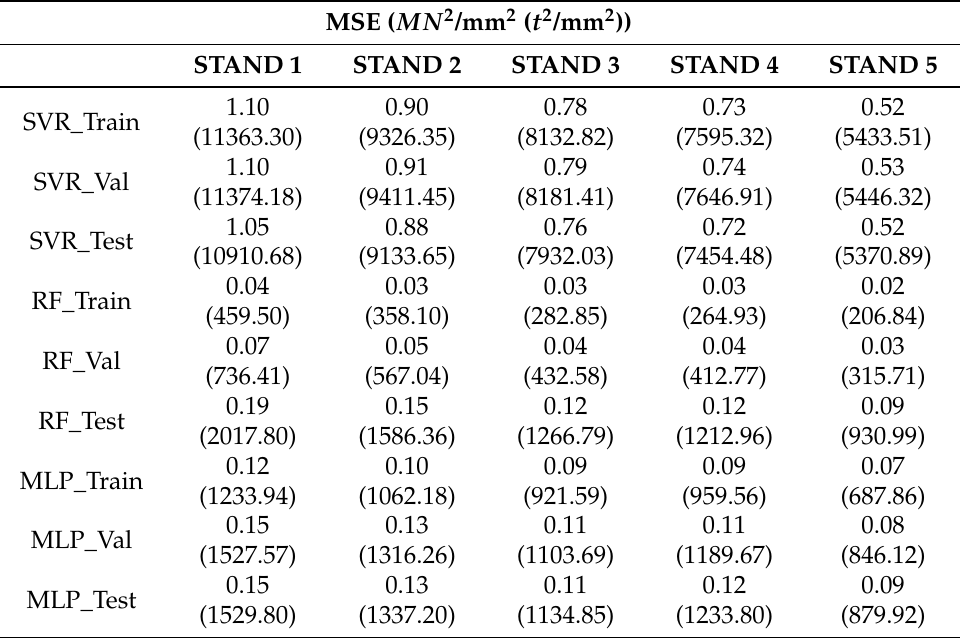
Table 17. Comparison with a baseline of machine learning methodologies for roll force prediction using